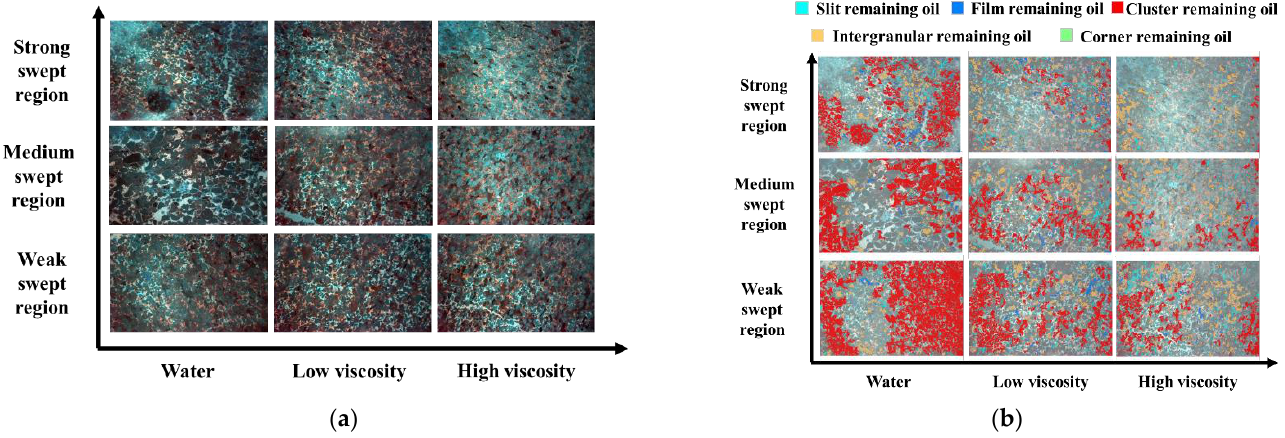
Figure 9. The occurrence of the remaining oil. ( a ) The ultraviolet fluorescence images; ( b ) the recognized remaining oil.